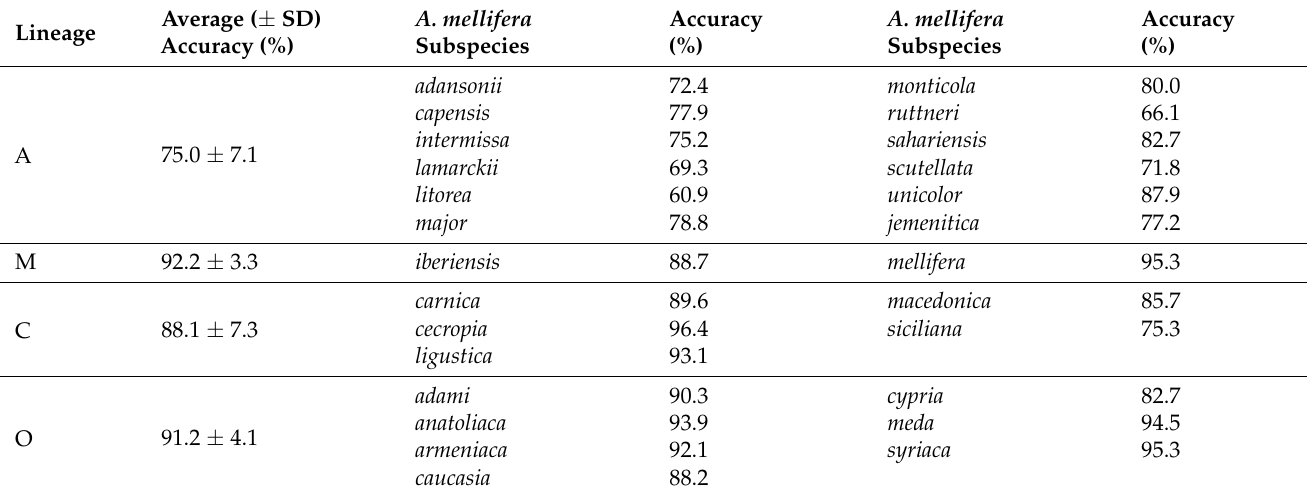
Table 5. Classification accuracy obtained for the 26 A. mellifera